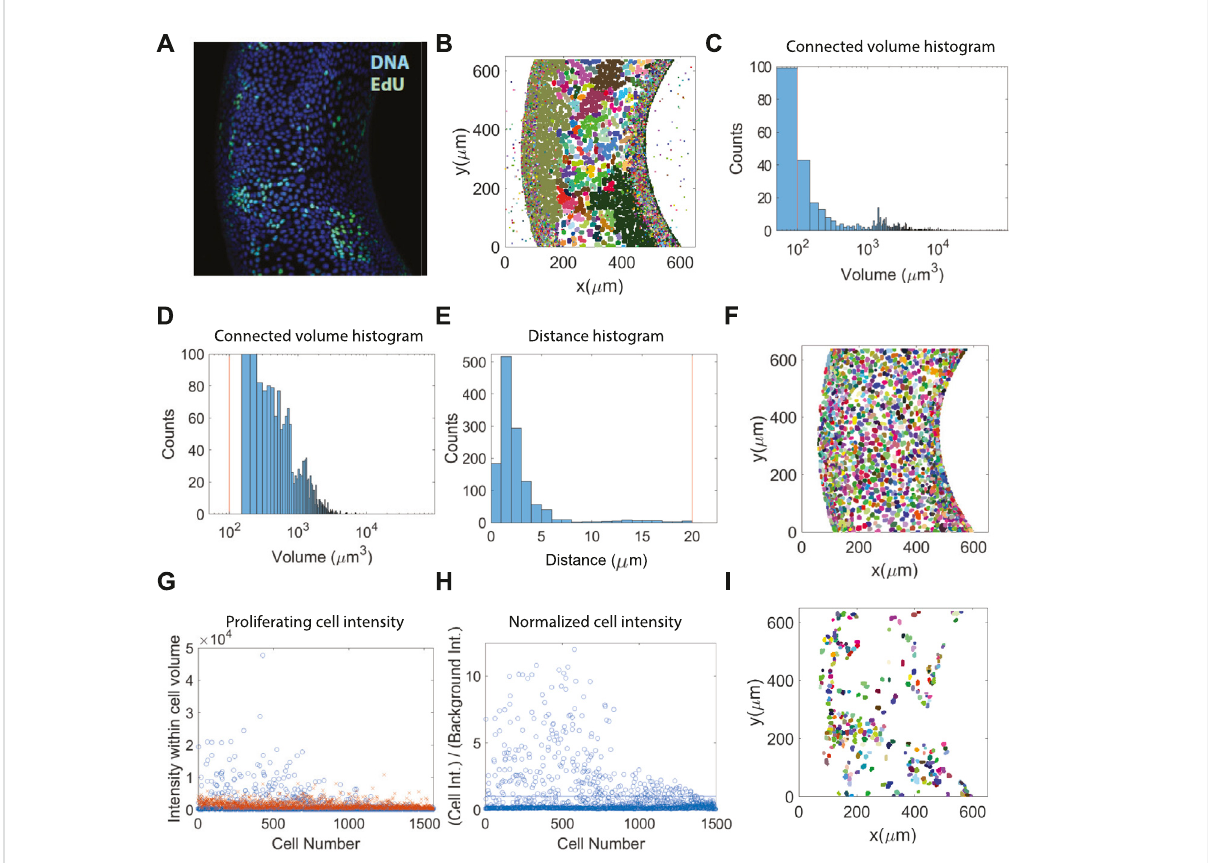
FIGURE 5 Proliferation and nuclei data segmentation results. (A) Merged maximum intensity projection from the whole nuclei staining (DNA) and proliferation channel (EdU). (B) xy-projected view of processed nuclei data showing connected volume elements. (C,D) Cell volume histogram before (C) and after (D) segmentation. (E) Histogram of cell centroid-to-surface distance. The vertical line at 20 μ m is the cut-off distance. (F) xy- projected view of processed nuclei data after segmentation. (G) Sum of voxel intensities in every cell volume of all cells as detected in the proliferation (EdU) channel. The crosses represent the corresponding background intensity, as de fi ned in the text. (H) Normalized cell intensity over background intensity for all cell volumes. The horizontal line marks the intensity cutoff for proliferating cells. (I) xy-projected view of proliferating cells using the I cell / I b = 1 cutoff